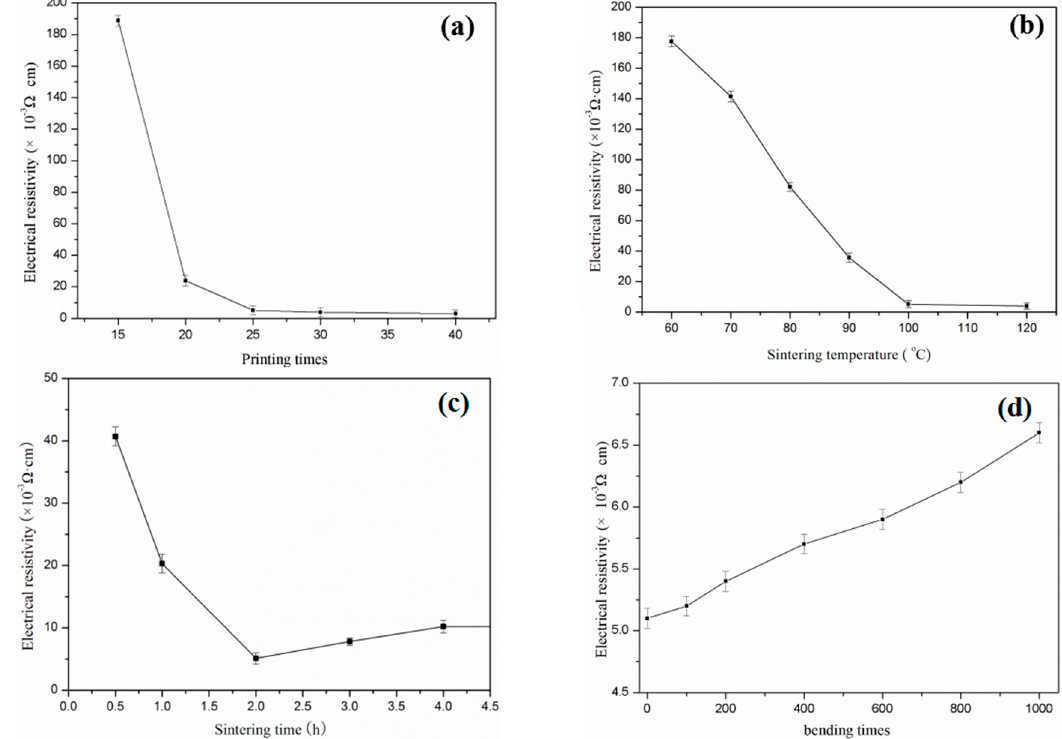
Figure 9. The resistivity of the printed Ag patterns with: ( a ) different printing times; ( b ) different sintering temperature; ( c ) different sintering time; and ( d ) different bending times.